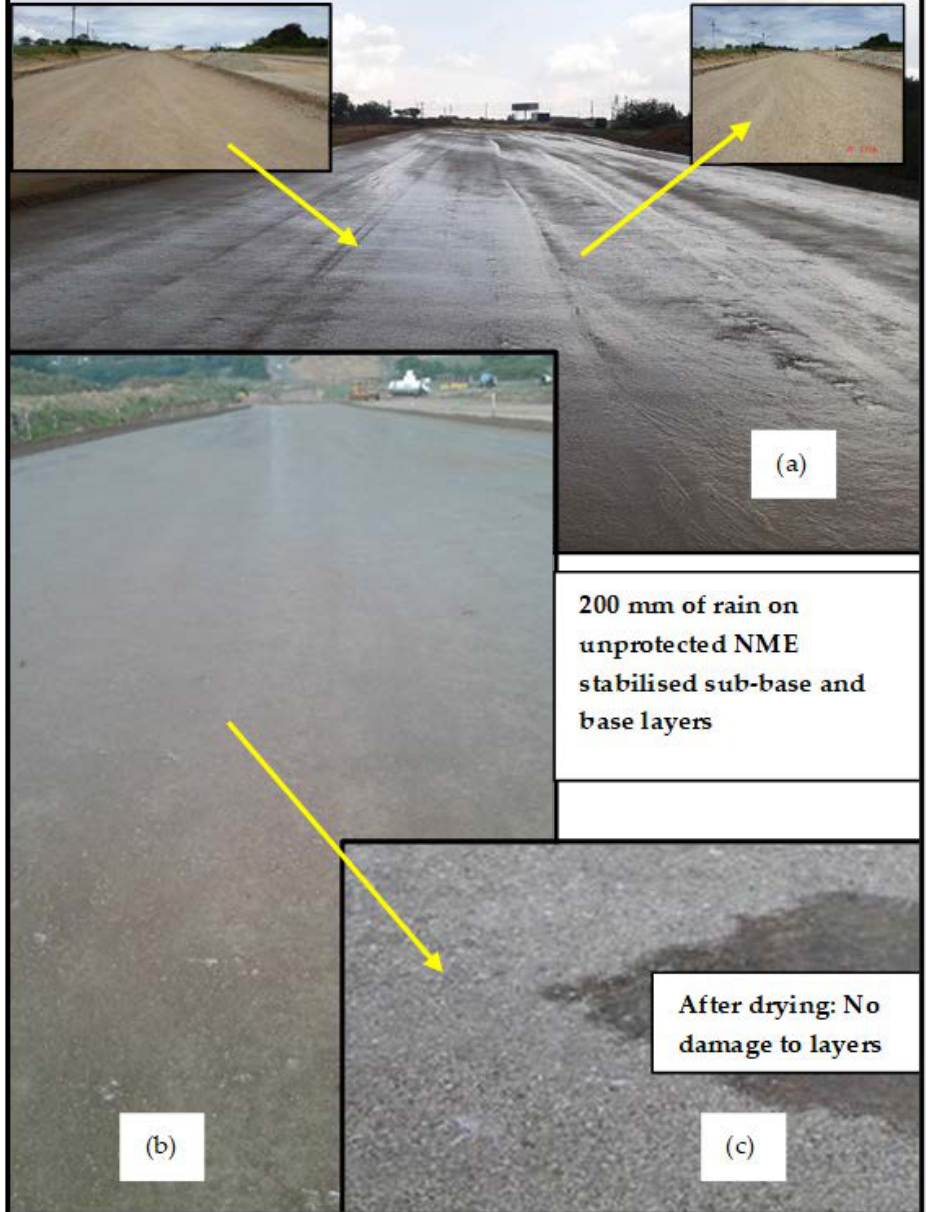
Figure 9. One week after placement of base (1.2% NME—0.7% residual bitumen) and the exposed sub-base (0.7% NME—0.4% residual bitumen), 200 mm of rain fell with ( a ) the sub-base-layer and ( b ) base-layer representing rivers. ( c ) After drying, no water-related damage could be observed.